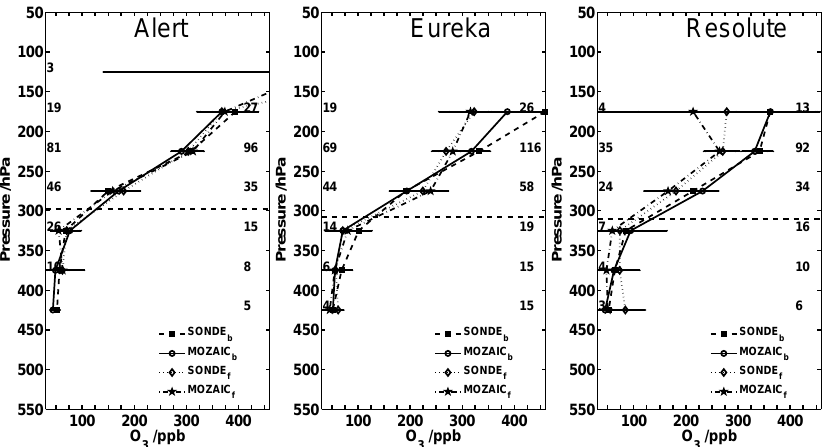
Fig. 12. 16 yr average (1994–2009) O 3 profiles from sondes flown at Alert, Eureka, and Resolute compared to O 3 profiles from MOZAIC. Fig. 12. 16-year average (1994-2009) O 3 profiles from sondes flown at Alert, Eureka, and Resolute, Data are grouped into 50hPa layers. Numbers on the left and right indicate the number of soundings using 6day backward-only (subscript and from MOZAIC. Data are grouped into 50 hPa layers. Numbers on the left and right indicate the b) and forward-only trajectories (subscript f), number of soundings using 6-day backward-only (subscript b) and forward-only trajectories (subscript f), respectively.